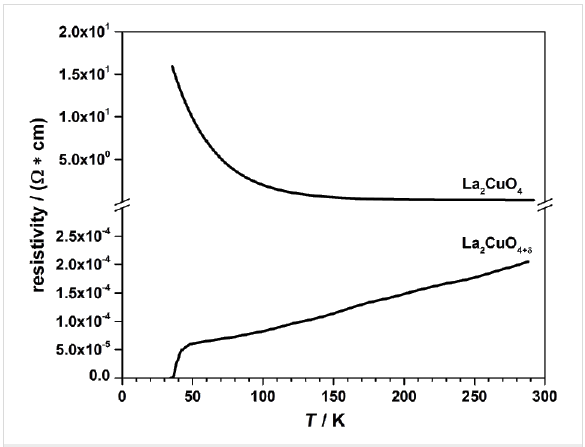
Figure 6: Resistivity versus temperature for the parent compound La 2 CuO 4 and for the superconducting La 2 CuO 4+ δ